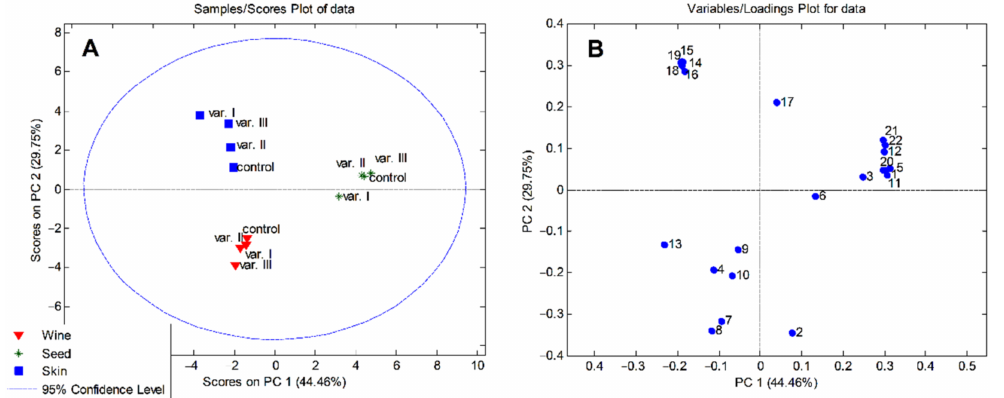
Figure 1. Principal component analysis relating to phenolic profiles of grape seeds, skins and wines: ( A ) score plot and ( B ) loading plot (numbers of variables correspond to Table